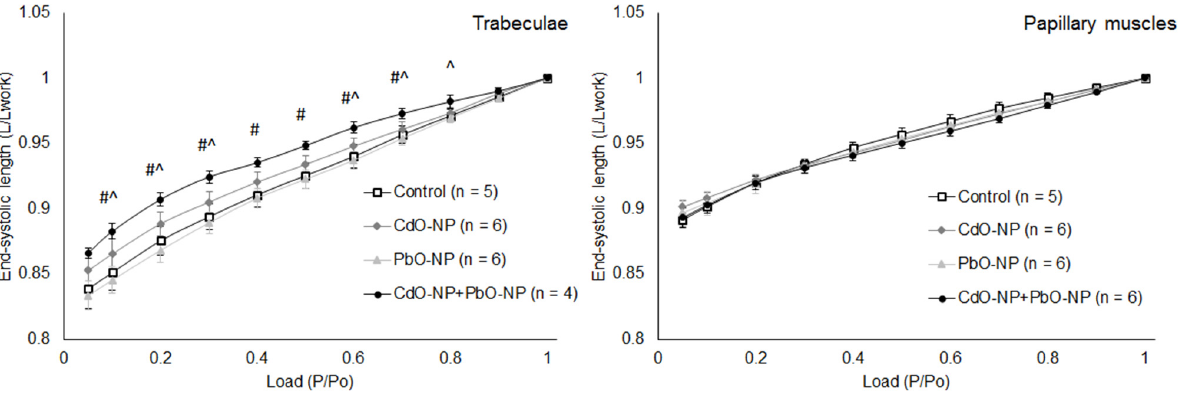
Figure 7. The end–systolic length–afterload relationships of isolated trabeculae (left panel) and papillary muscles (right panel). Data are shown as mean ± s.e. There are significant differences: #—CdO–NP + PbO–NP vs. Control, ^—CdO–NP + PbO–NP vs. PbO–NP NP ( p < 0.05, Mann–Whitney U- test).